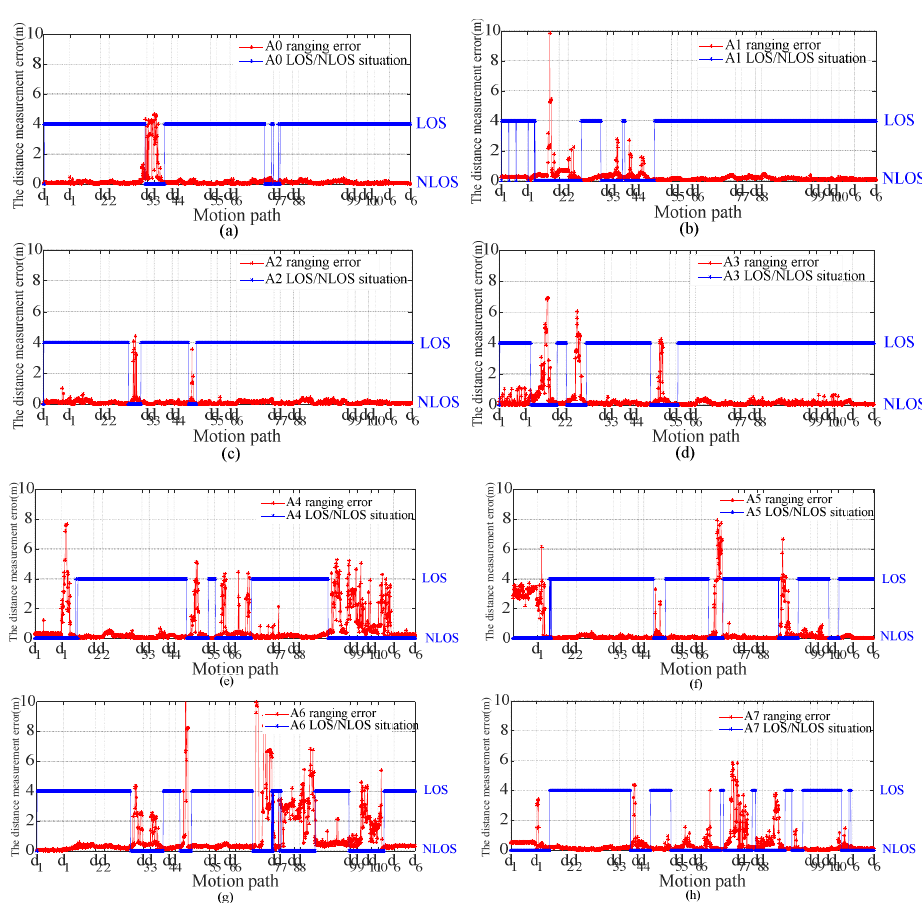
Figure 14. Comparison of LOS selection and the ranging error of each anchor on the path of Experiment 1. ( a ) A0 situation; ( b ) A1 situation; ( c ) A2 situation; ( d ) A3 situation; ( e ) A4 situation; ( f ) A5 situation; ( g ) A6 situation and ( h ) A7 situation.